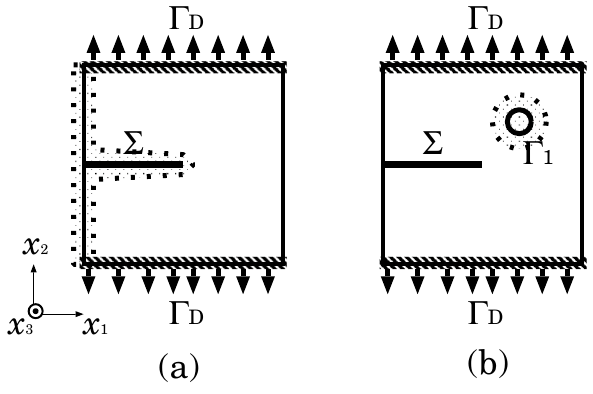
Fig. 20 Two typical situations of hydrogen-assisted cracking. The hydrogen is supplied from a the left boundary, and b the surface Γ 1 ∶= 𝜕 H . We suppose that the hydrogen reservoir makes contact with the left wall in setup a and that hole H is filled by hydrogen gas in